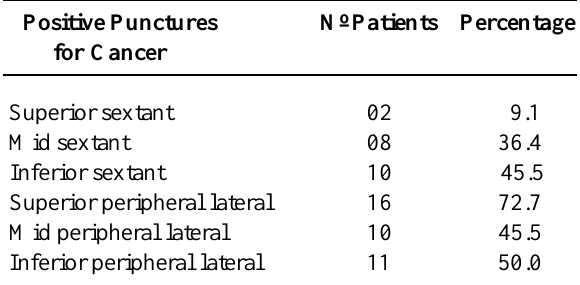
Table 1 – Regions of the positive punctures for